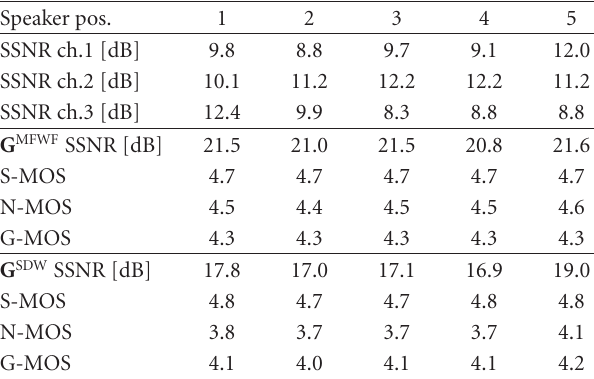
Table 4: Simulation results for the system in a simulated conference environment with T 60 = 0 .